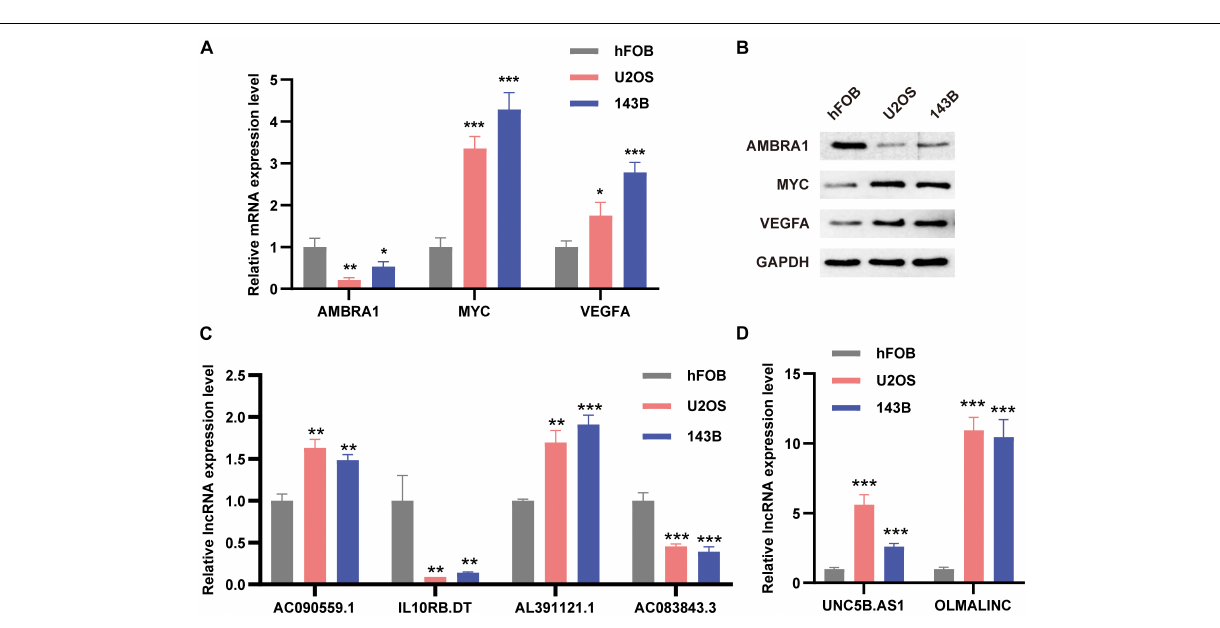
FIGURE 10 | The expression levels of ARGs and ARLs in osteosarcoma cell lines were compared with those of osteoblasts. (A) The qRT-PCR result of the three ARGs was evaluated by the 2– (cid:49)(cid:49) CT method. (B) Western blotting results of AMBRA1, MYC, and VEGFA expression. (C,D) The qRT-PCR result of the six ARLs was evaluated by the 2- (cid:49)(cid:49) CT method. The data are expressed as mean ± standard deviation. * P < 0.05, ** P < 0.01, and *** P <